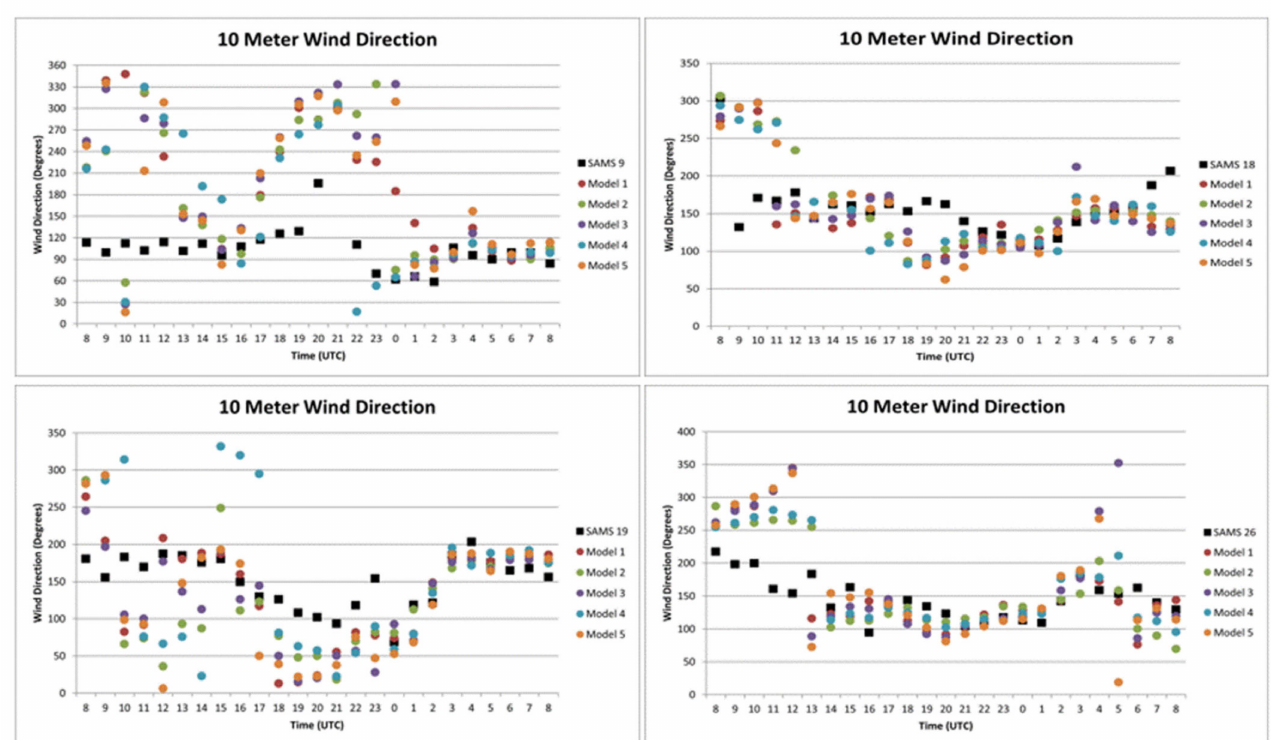
Figure 10. Observed 10 m AGL surface wind direction ( ◦ ) compared with model-simulated 10 m AGL surface wind direction ( ◦ ) for the different experiments across IOP6 at several different SAMS playa sites as shown in Figure 1. From top left to bottom right: Sites 9, 18, 19, and 26.